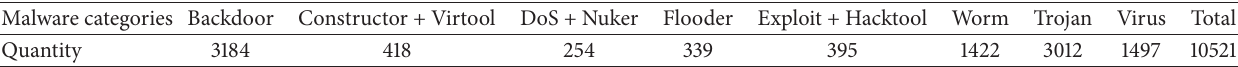
Table 1: The distribution of PE format malware.